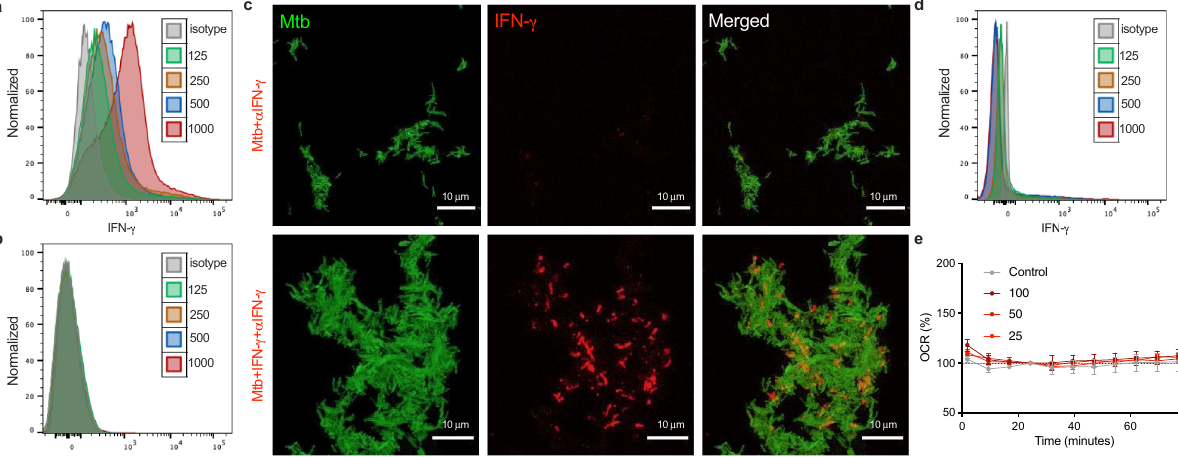
Fig. 2 IFN- γ binds to surface of Mtb but not BCG. Flow cytometry shows that recombinant human IFN- γ ( a ) but not recombinant human TNF- α ( b ) binds to Mtb in a dose-dependent manner at the indicated concentrations (ng/mL). Confocal microscopy con fi rmed binding of recombinant human IFN- γ to individual Mtb -GFP ( c ). Top panel shows control sample; bottom panel shows fully stained sample. In contrast to Mtb , BCG does not bind IFN- γ ( d ) nor increase respiration in response to IFN- γ at the indicated concentrations (ng/mL) ( e ). Data are shown as mean ± SEM of n = 3 – 5 technical replicates and represent at a minimum two independent experiments. Tukey ’ s correction multiple-comparison test was used for the statistical analysis.